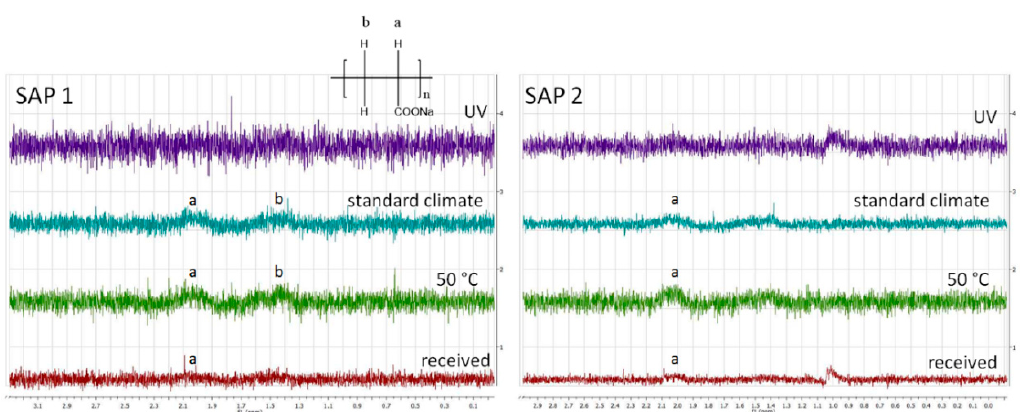
Figure 6. 1 H-NMR spectra of both SAPs swollen in D 2 O after being subjected to the different storage conditions.